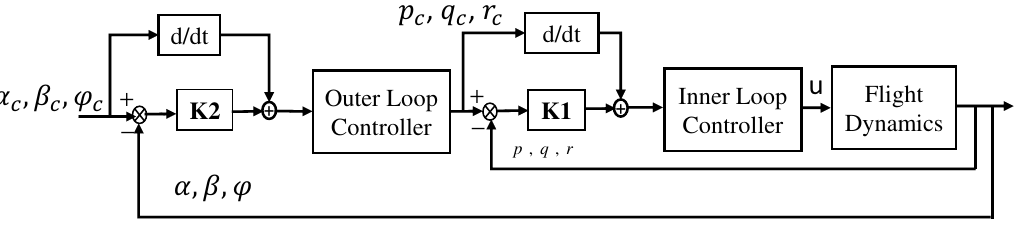
Figure 3. Two-timescale dynamic inversion